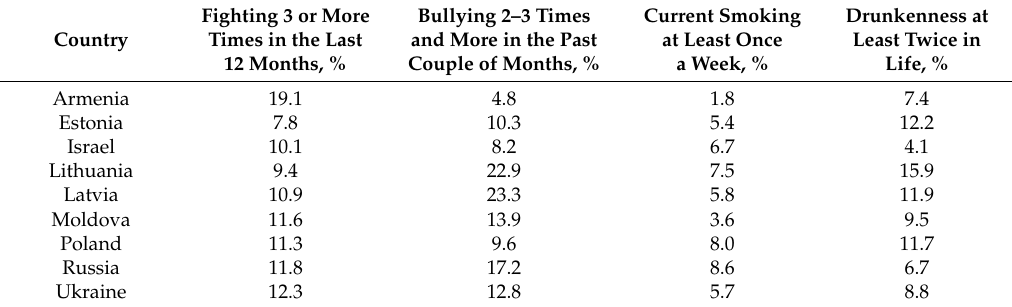
Table 4. Prevalence of violent and health risk behaviours among school children by country. Bullying 2–3 Times Fighting 3 or More and More in the Past Country Times in the Last 12 Months, % Couple of Months, %